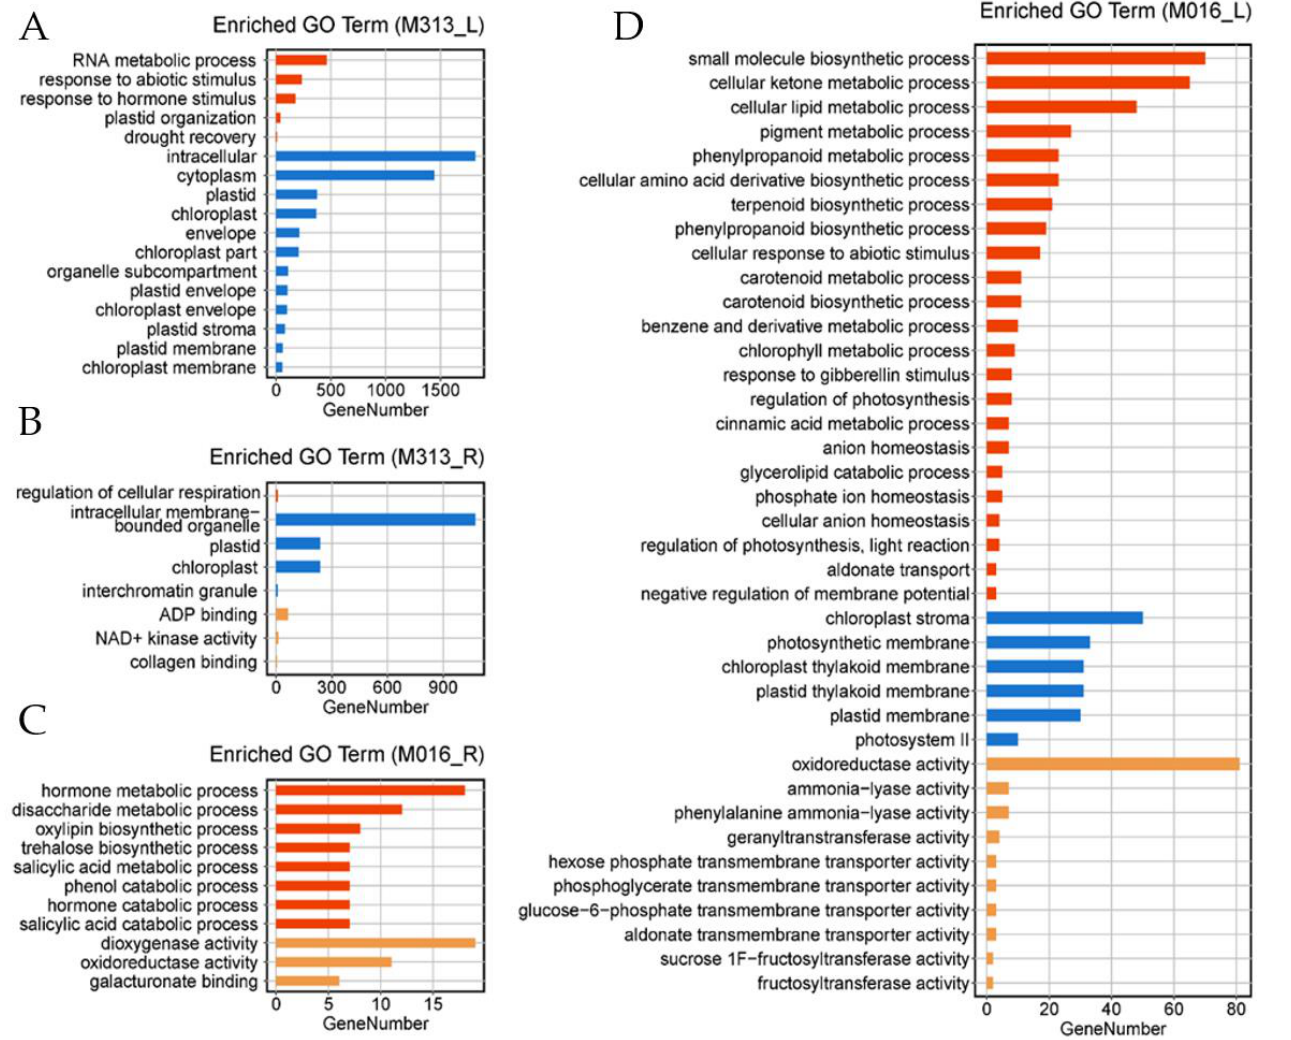
Figure 3. Histogram of GO (Gene Ontology) annotation of up-regulated genes in diploid and tetraploid M. lutarioriparius under drought treatment. ( A ) Enriched GO terms in leaves of M313. ( B ) Enriched GO terms in roots of M313. ( C ) Enriched GO terms in roots of M016. ( D ) Enriched GO terms in leaves of M016.